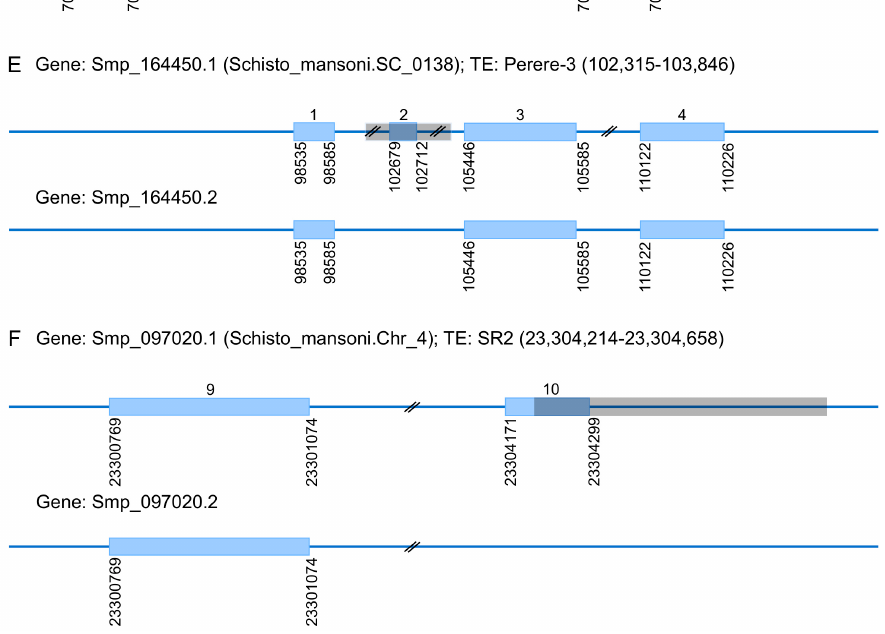
Figure 1. Schematic representation of the S. mansoni genes with a TE-derived sequence into coding regions. The blue rectangles represent the coding regions, and the gray transparent rectangles represent TE sequences. The instances pictured were previous confirmed by EST or RNAseq data [81]. Figure adapted from [81].